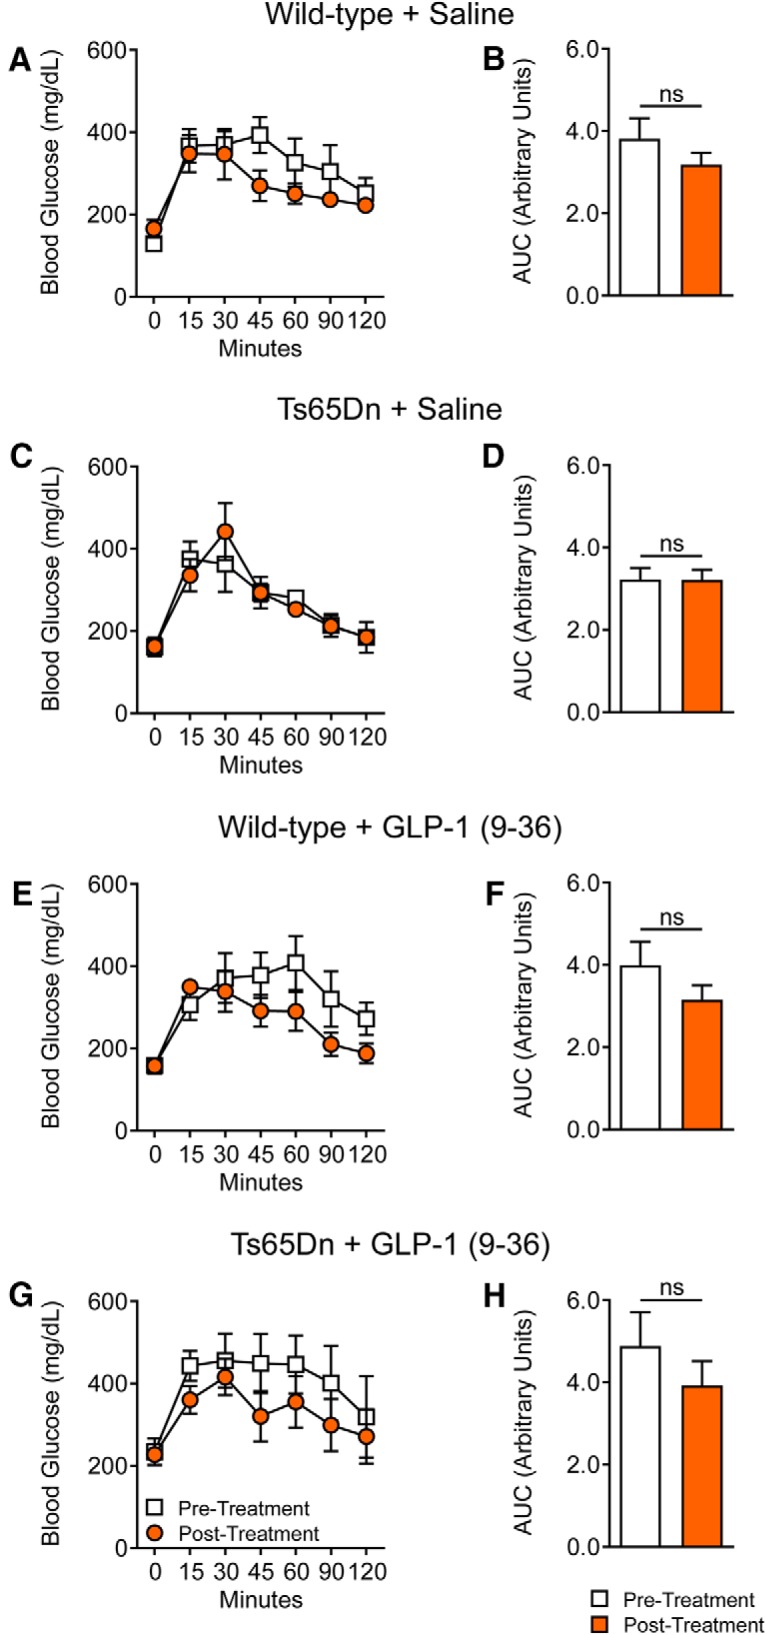
GLP-1 (9-36) treatment does not affect glucose clearance following glucose tolerance tests. Glucose tolerance test (GTT) of WT and Ts65Dn mice was performed before and after saline or GLP-1 (9-36) treatments. A, C, E, G, Two-way ANOVA revealed no significant differences between pretreatment or post-treatment in glucose response curves among all four experimental groups. B, D, F, H, Independent t test revealed no significant differences between pretreatment or posttreatment GTT AUC. WT + Saline: n = 6; Ts65Dn + Saline: n = 5; WT + GLP-1 (9-36): n = 8; Ts65Dn + GLP-1 (9-36): n = 6.